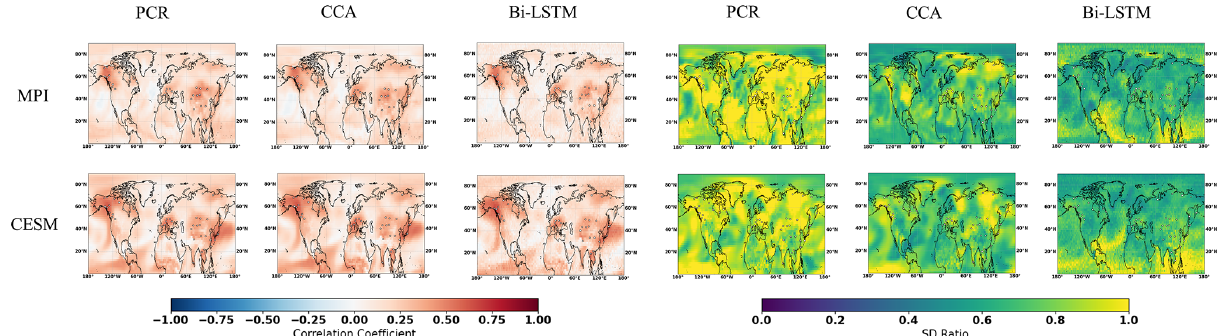
Figure 6. The same as Fig. 5 but for employing the full 48-pseudoproxy network with white noise contamination.